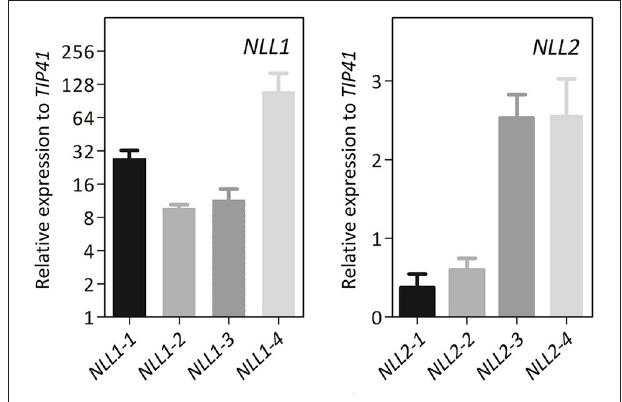
FIGURE 6 | Gene expression analysis of 4-week-old transgenic Arabidopsis plants overexpressing GmNLL1 or GmNLL2 . Normalized relative expression to reference gene TIP41 of two biological replicates is represented (error bars represent standard